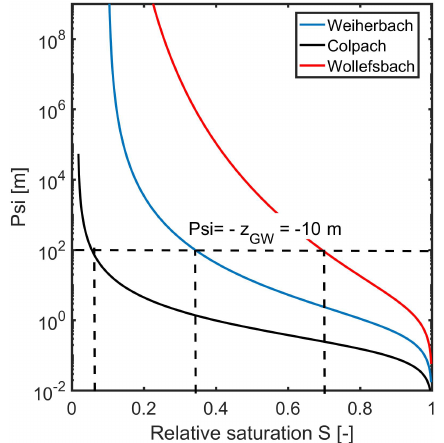
Figure 1. Soil water retention curves as a function of relative satu- ration determined as explained in Sect. 3.1. The dashed black lines mark the relative saturation at hydraulic equilibrium, assuming ar- bitrarily a depth to groundwater of z GW = 10m. The Wollefsbach and the Colpach are further characterized in Sect. 3; the Weiherbach is used here for purposes of comparison and is briefly described in Sect.